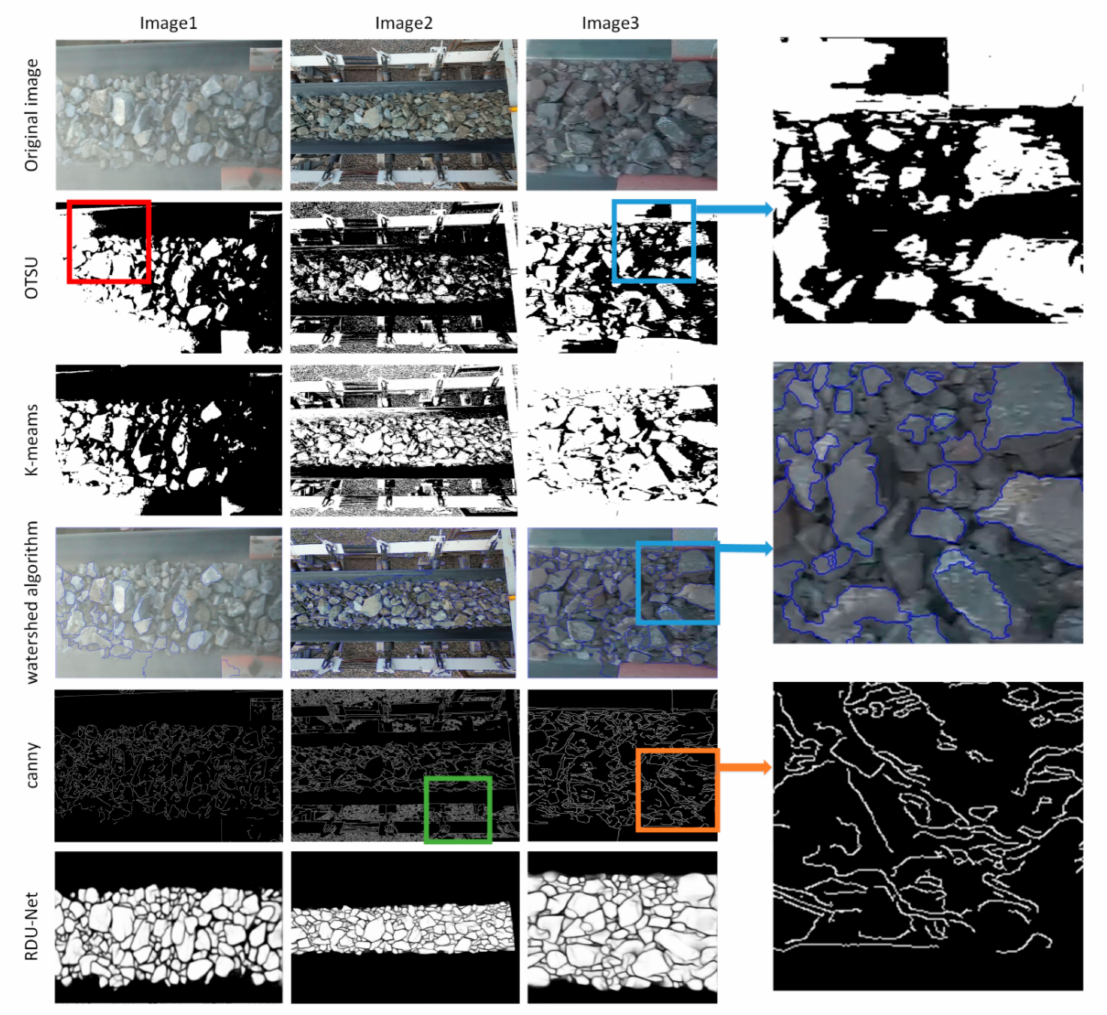
Figure 9. Comparison with Canny algorithm, Otsu algorithm, watershed algorithm and k-meams